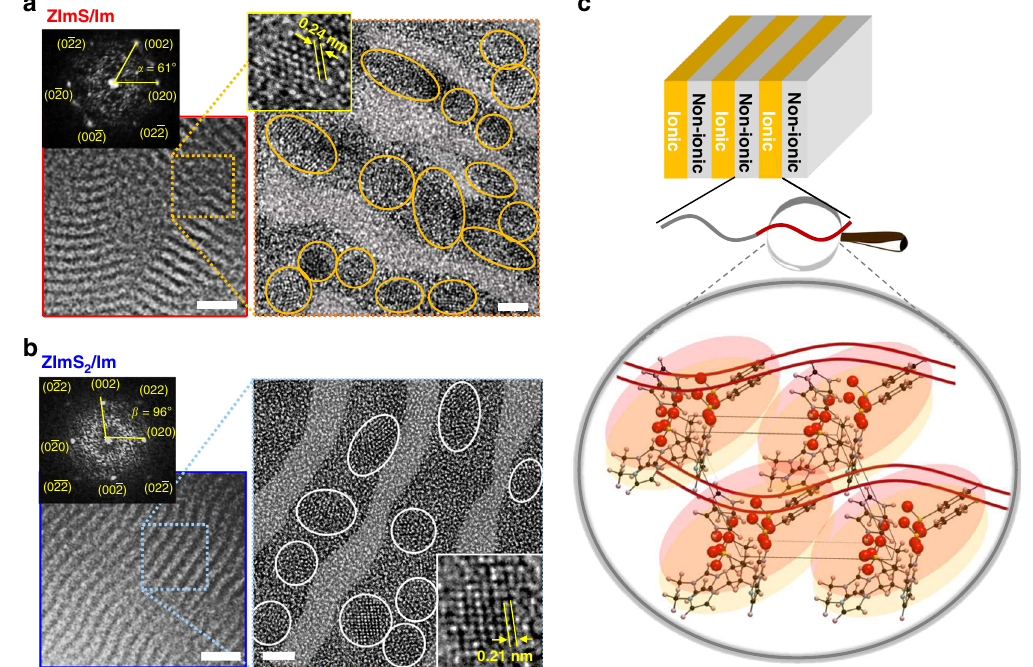
Fig. 4 Ionic crystals in self-assembled lamellar grains. Bright- fi eld TEM, high-resolution TEM micrographs, and FFT patterns obtained from PSS:Im- b -PMB with the addition of a ZImS/Im and b ZImS 2 /Im. The darkened area of lamellae indicates PSS:Im phases for both samples and ionic crystals are marked by circles in each TEM image for clarity. Scale bars in bright- fi eld TEM and high-resolution TEM images are 20 nm and 2 nm, respectively. c Schematic illustration of the formation of ionic crystal in ionic phases of lamellar grains for PSS:Im- b -PMB with ZImS/Im